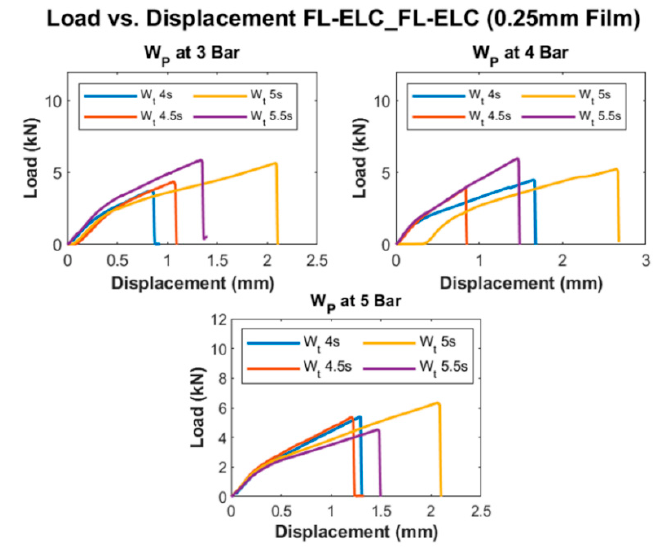
Figure 18. Load vs. Displacement curve of FL-ELC_FL-ELC (0.25 mm film ED).